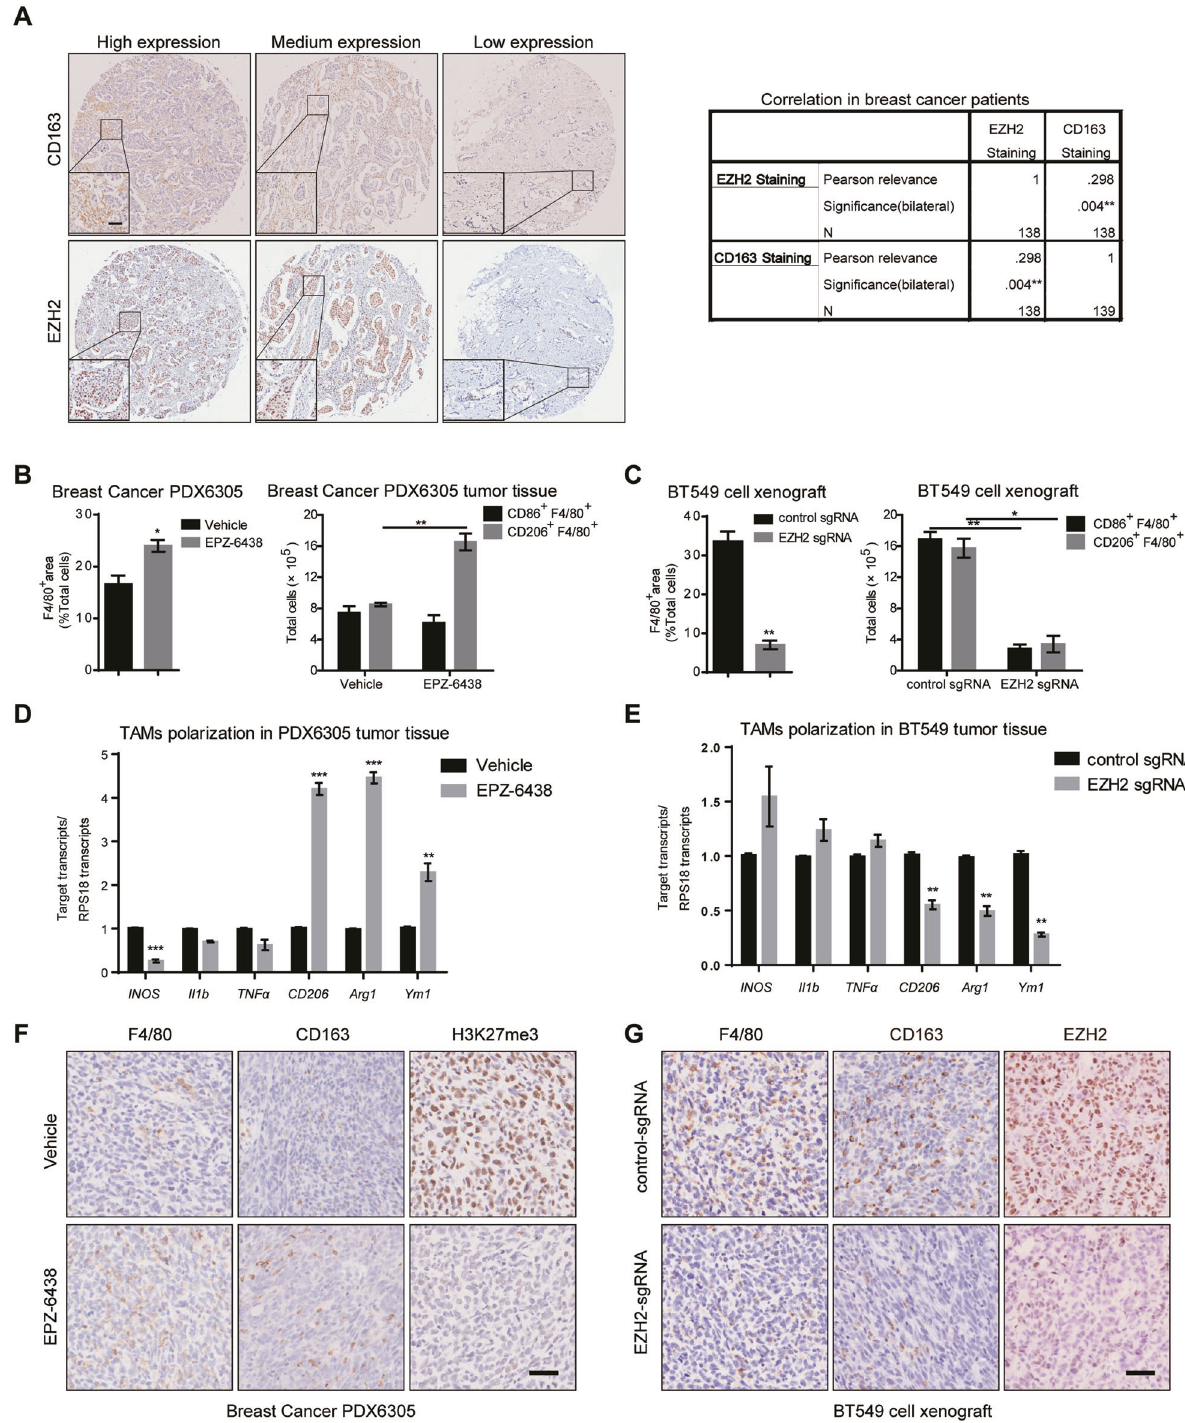
Fig. 1 EZH2 depletion and inhibition differently affects BC cell growth and TAMs polarization. A Expression and the correlation of CD163 and EZH2 were examined by IHC in breast cancer patients from a tissue microarray ( n = 139). Scale bar, 50 μ m. The percentage of total macrophages, M1 and M2 macrophages in 200 mg/kg/day EPZ-6438-treated PDX6305 tumor tissues B and BT549 EZH2-knockdown tumor tissues C were analyzed by fl ow cytometry. RT-qPCR was applied to detect the expressions of M1 markers ( iNOS, Il1b, TNF α ) and M2 markers ( CD206, Arg1, Ym1 ) in EPZ-6438-treated PDX6305 tumor tissues D or BT549 EZH2-knockdown tumor tissues E . F Immunohistochemistry of F4/ 80, CD163 and H3K27me3 in tumor tissues treated with or without EPZ-6438. G Immunohistochemistry of F4/80, CD163 and EZH2 in mock and EZH2 knockdown tumor tissues. Scale bar, 50 μ m. In B – E , all data were shown as mean values ± SD ( n = 3). Statistical signi fi cance was addressed using unpaired, two ‐ tailed Student ’ s t ‐ test, * p < 0.05, ** p < 0.01, *** p < 0.001, NS, not signi fi cant. The statistical signi fi cance was calculated compared to the negative control (NC) in each group. The shown were representative of replicates and the experiments were repeated three times.